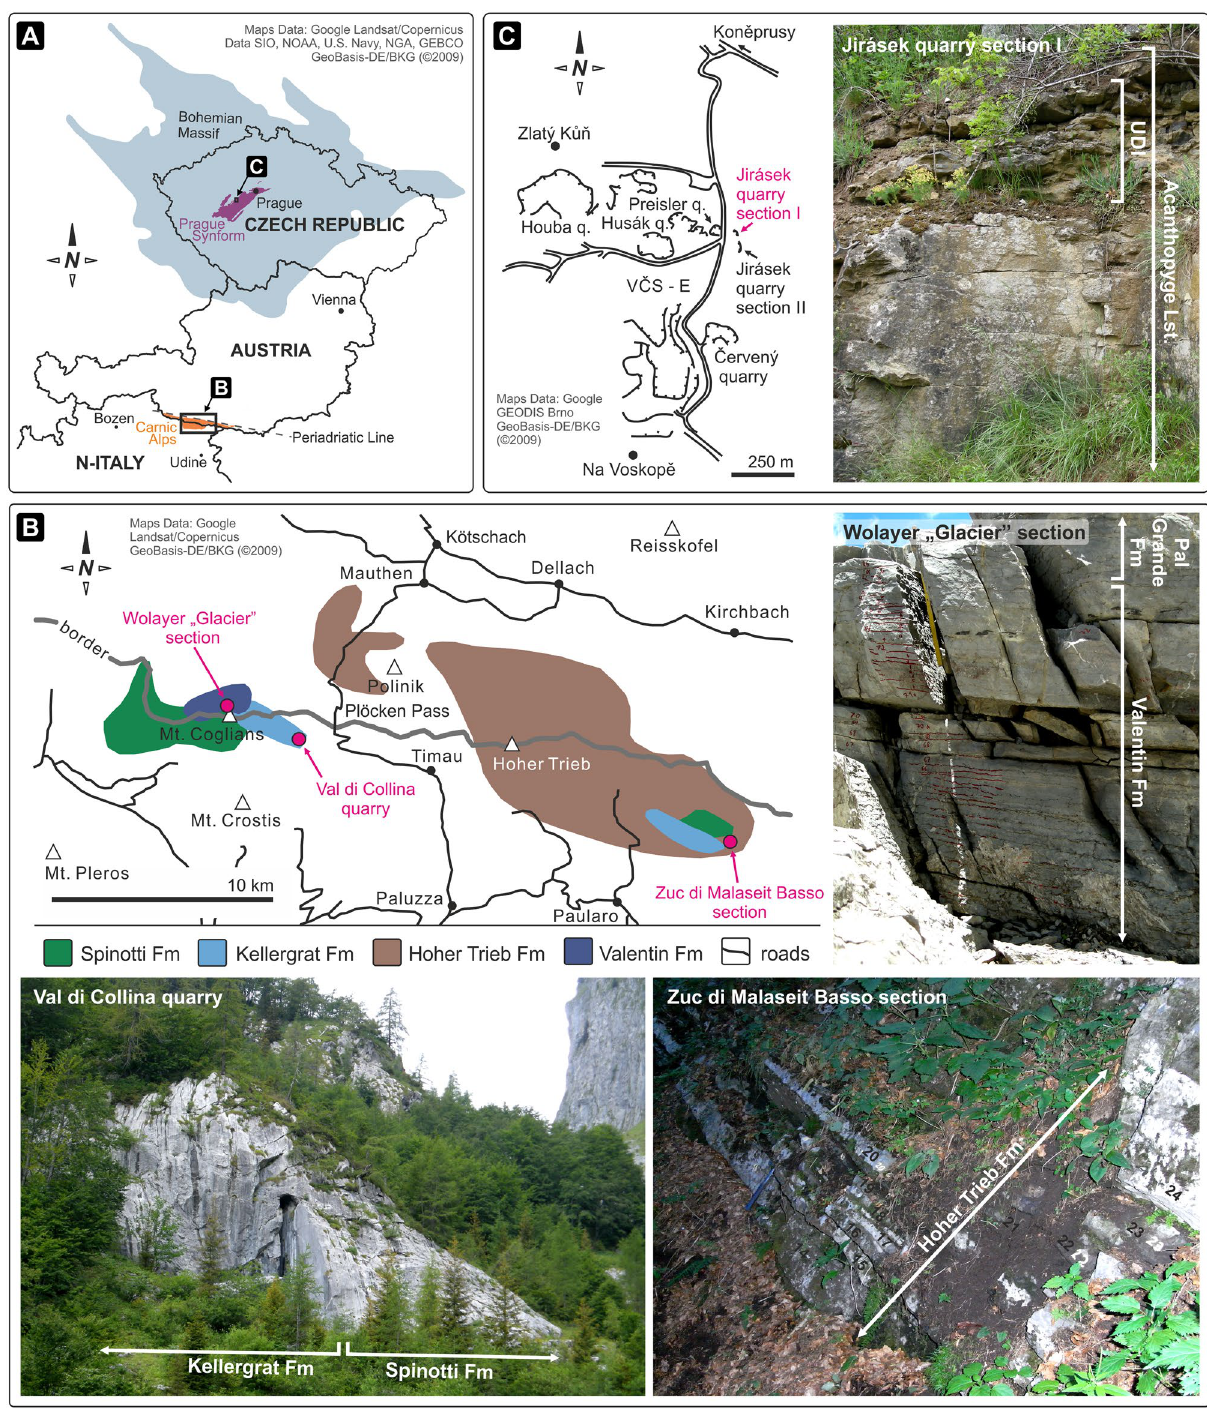
Figure 2. ( A ) Location of the Carnic Alps at the Austro-Italian border and the Prague Synform in Czech Republic. ( B ) Simplified map of the central Carnic Alps with areas of occurrence of the formations analysed in this paper. Investigated sections are the Wolayer “Glacier” section (Valentin Formation), the Val di Collina quarry (Spinotti and Kellergrat formations) and the Zuc di Malaseit Basso section (Hoher Trieb Formation). ( C ) Detailed map of the Koněprusy area with location of the Jirásek quarry section I and II. The photo left of the map shows the Upper Dark Interval (UDI) of the uppermost part of the Acanthopyge Limestone at Jirásek quarry section I. Maps in ( A – C ) designed in CorelDRAW ® X8 based on google earth images (maps data attribution incorporated within